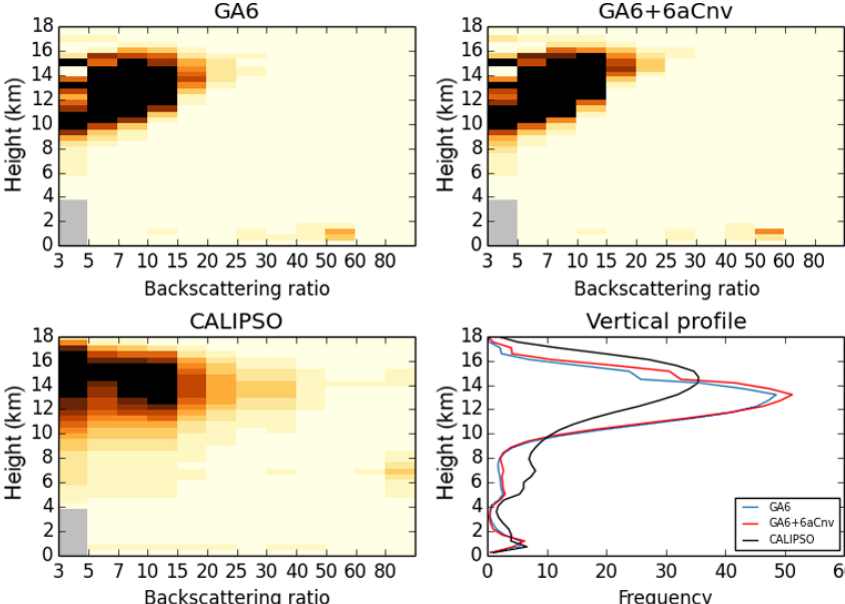
Figure 5. Histograms of height vs. 532nm lidar backscatter ratio over the tropical warm pool, showing CALIPSO observations and simulated climatologies of CALIPSO data from 20-year N96 atmosphere/land-only climate simulations using GA6.0 and GA6.0 plus the 6A convection scheme.